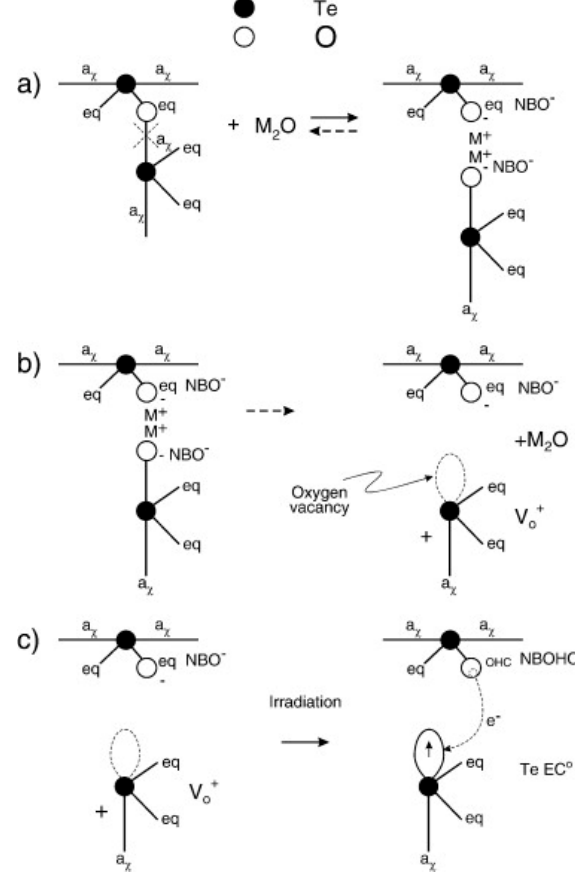
Figure 5. Formation of some defects. ( a ) Alkali oxide M 2 O and a BO react and form a pair of NBOs. ( b ) The reaction is partially reversed and a V 0 defect forms. ( c ) Further irradiation results in electron transfer and formation of an Te-NBOHC and a TeEC defects. Reproduced from [62]. Copyrights Elsevier 2010.